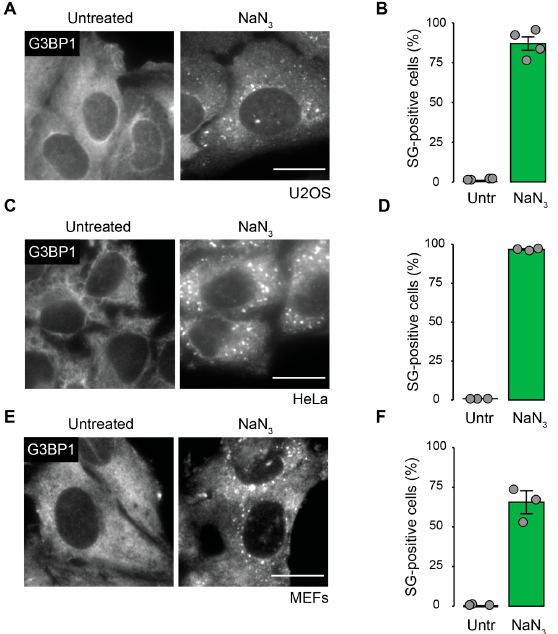
Figure 1. The inhibition of mitochondrial complex IV by NaN 3 induced SG formation in mammalian cells. Cells were left untreated or treated with NaN 3 for 2 h, then fixed and stained with anti-G3BP1 antibody for the detection of SGs. ( A ) SG formation in U2OS cells; scale bar = 20 µm. ( B ) Quantification of A. ( C ) SG formation in HeLa cells; scale bar = 20 µm. ( D ) Quantification of C. ( E ) SG formation in MEFs; scale bar = 20 µm. ( F ) Quantification of E. All graphs show mean value ± SD ( n ≥ 3 independent experiments; approximately 100 cells were analyzed per experiment and condition).